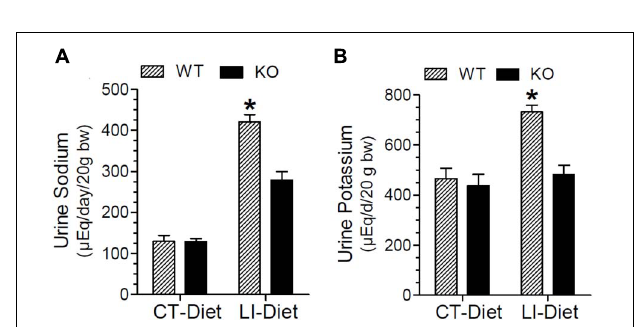
FIGURE 5 | Terminal urine sodium (A) and potassium (B) in WT and P2Y2 KO mice fed regular or lithium-added diets for 5 months. Values shown are mean ± se (CT; n = 5 mice/genotype; LI; n = 10 mice/genotype). Statistical significance between the groups is shown over the bars. ∗ Significantly different from the CT-Diet fed WT mice and LI-Diet fed KO mice groups by one-way ANOVA. For the results of two-way ANOVA refer to Table 1